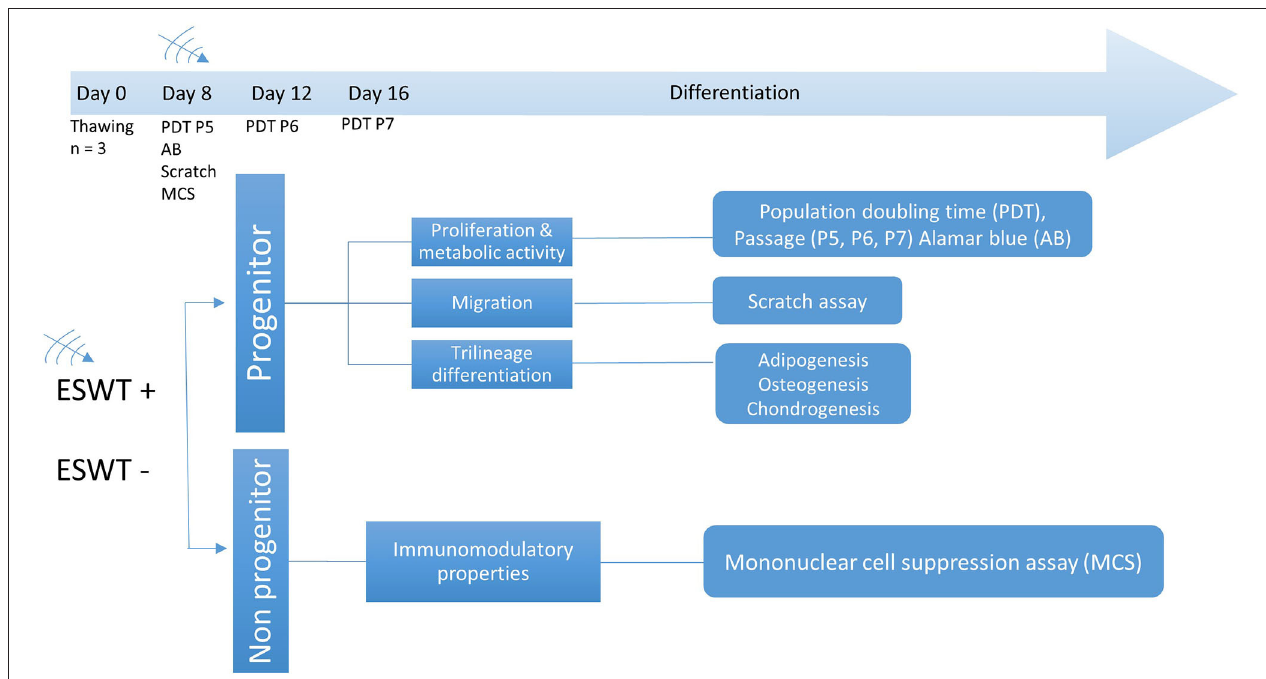
FIGURE 2 | Experimental design. Time points for ESWT, respective passage numbers (P5, P6, P7) and population doubling time (PDT), Alamar blue assay (AB), scratch (migration) assay, and mononuclear cell suppression assay (MCS). Differentiation was initiated after treatment on day